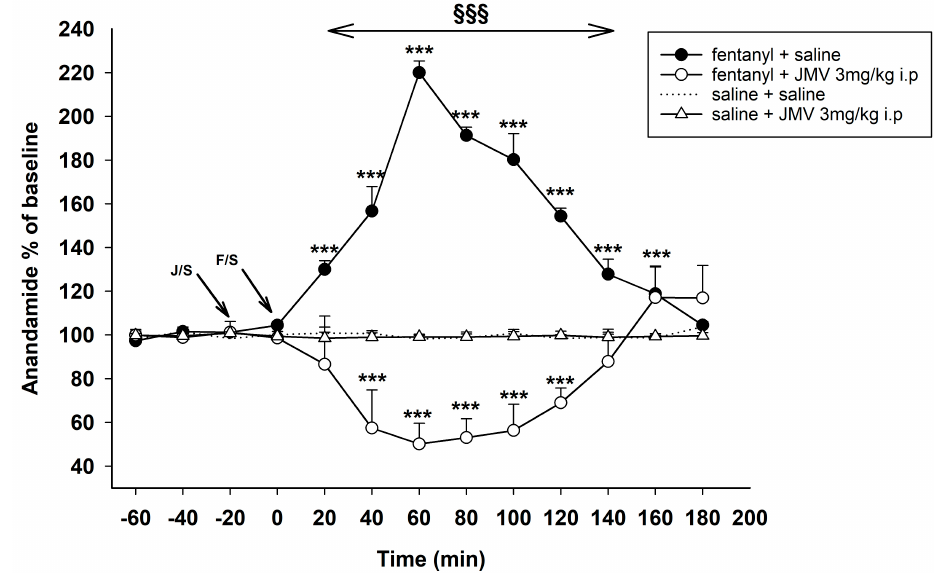
Figure 1. Effects of ghrelin receptor antagonist JMV2959 3 mg/kg administered